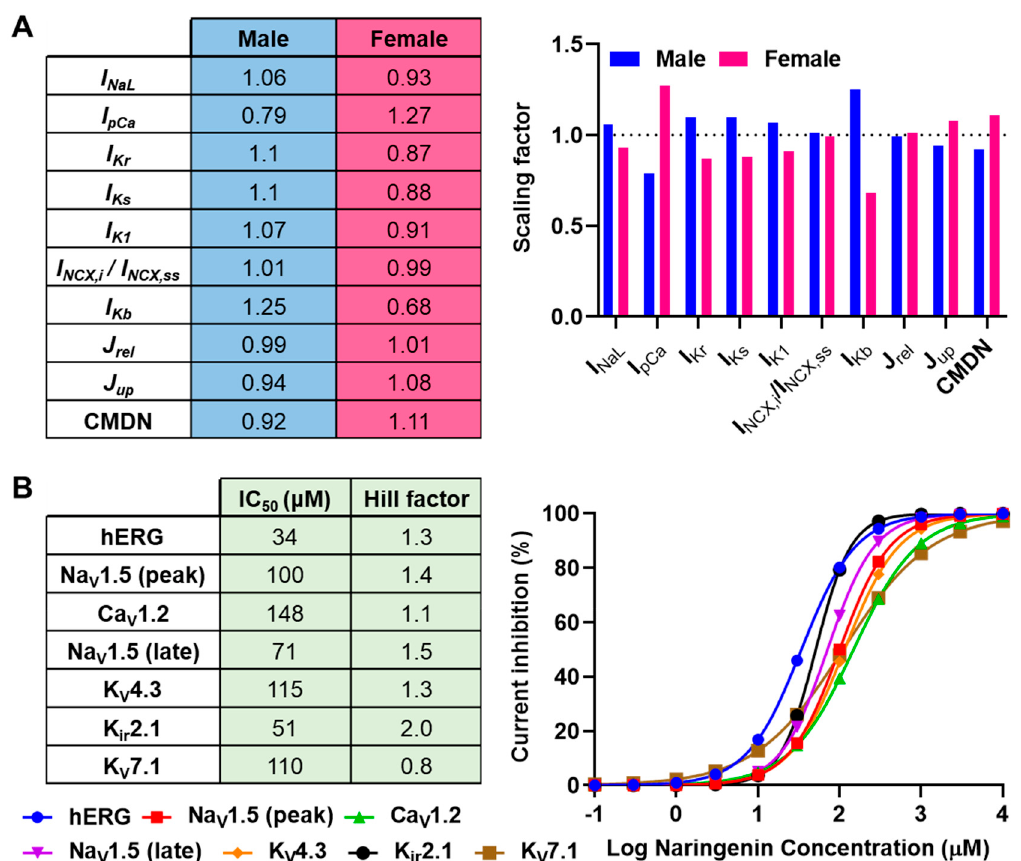
Figure 1. Sex-specific ionic modifications implemented in the human ventricular cardiomyocyte model and concentration-dependent inhibitions of cardiac ion channels by naringenin. ( A ) Ten Tomek–Rodriguez adaptations of O’Hara–Rudy (ToR-ORd) model parameters were modified to obtain sex-specific human ventricular endocardium electrophysiology. The scaling factors were obtained from Peirlinck, Sahli Costabal, and Kuhl [14]. ( B ) The concentration–response curves displaying the concentration-dependent inhibition of seven major cardiac ion channels together with the associated 50% inhibitory concentrations (IC 50 ) and Hill factors